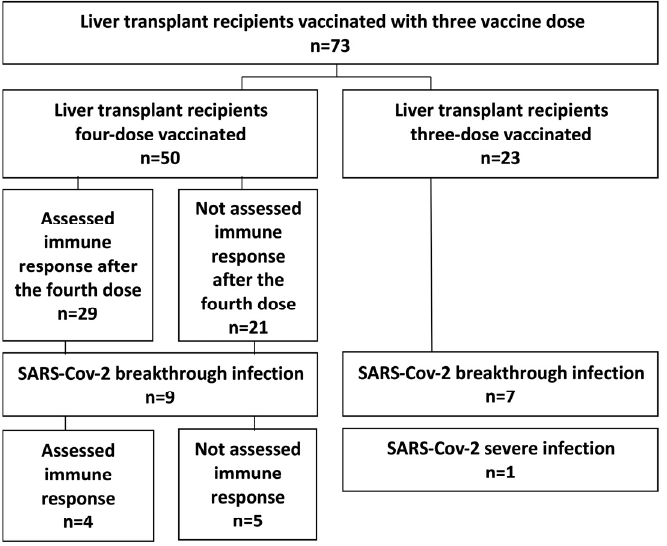
Figure 1. Flowchart of the study cohort.